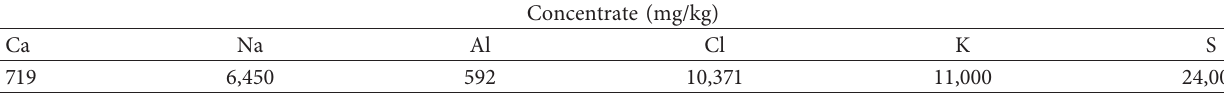
Table 2: Chemical test results in cocopith with AAS-Unpad method.